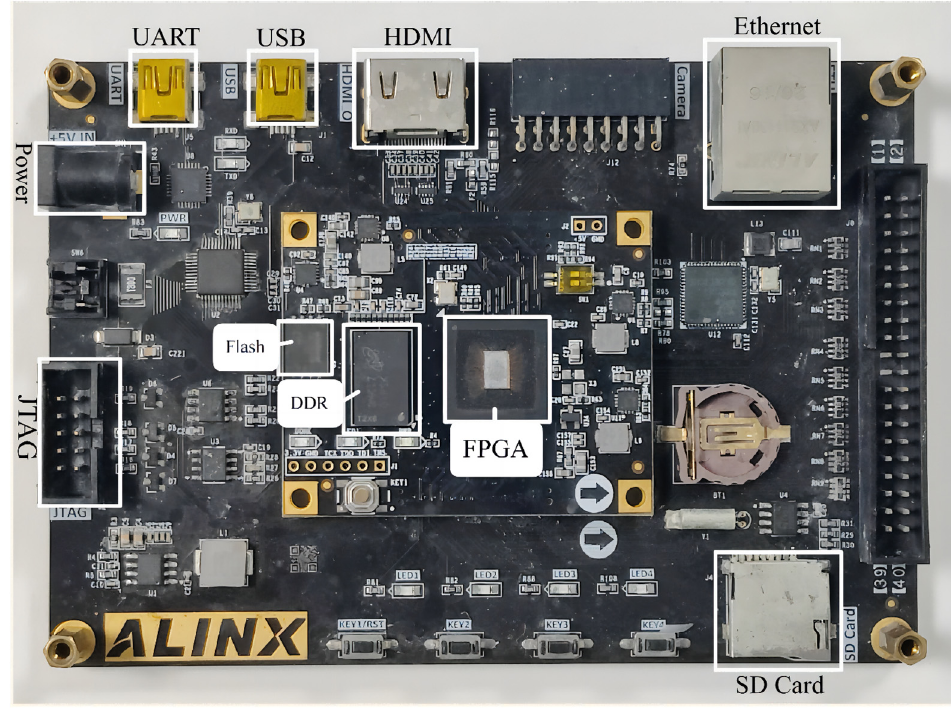
Figure 1. A picture of the PGL22G FPGA development board (unpacked chip). Table 1. List of resources for the PGL22G